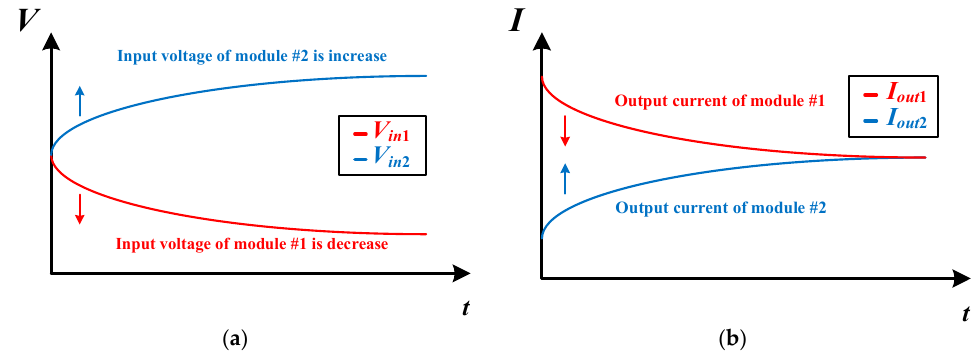
Figure 2. Operation principle of decentralized control method. ( a ) Individual input voltage of ISOP converter; ( b ) Individual output current of ISOP converter.